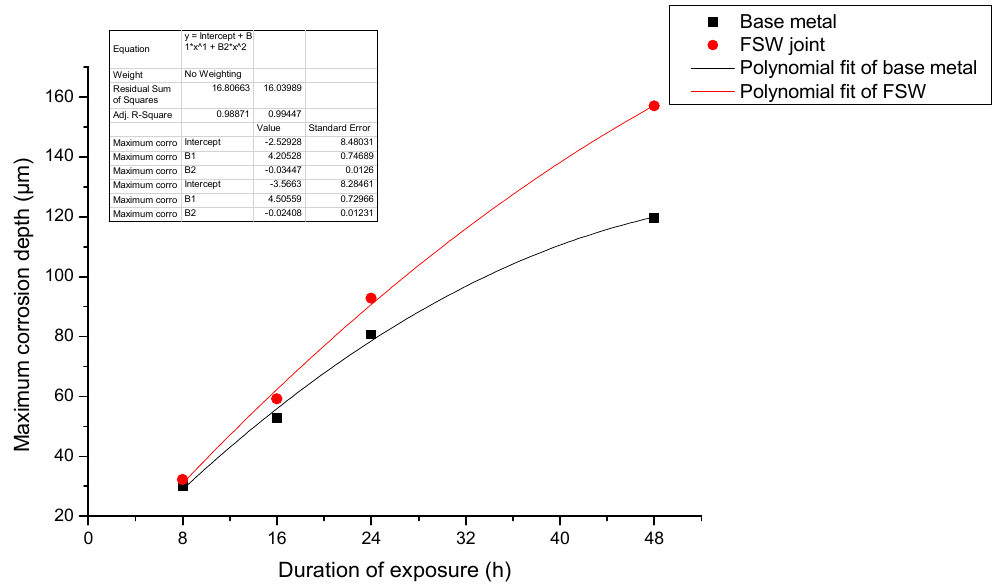
Figure 16. Variation of maximum corrosion depth ( µ m) with time of exposure (h) to the environment at an applied stress ( σ ) of 79 MPa.